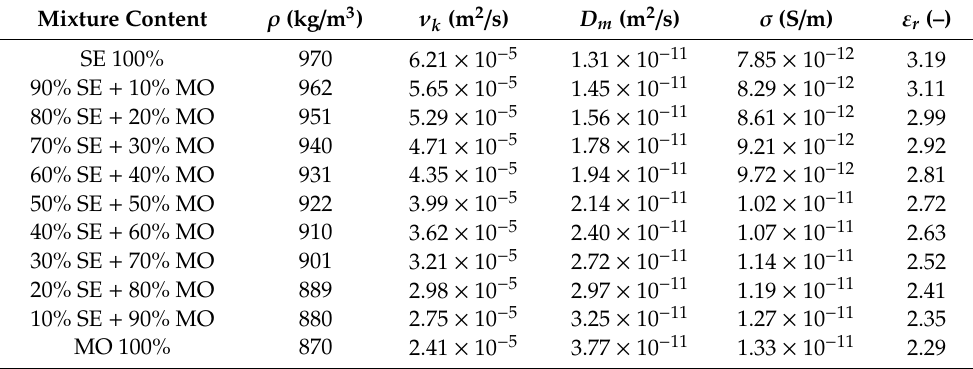
Table 2. Properties of Nycodiel 1255 synthetic ester and aged Trafo EN mineral oil mixtures (20 ◦ C). Mixture Content